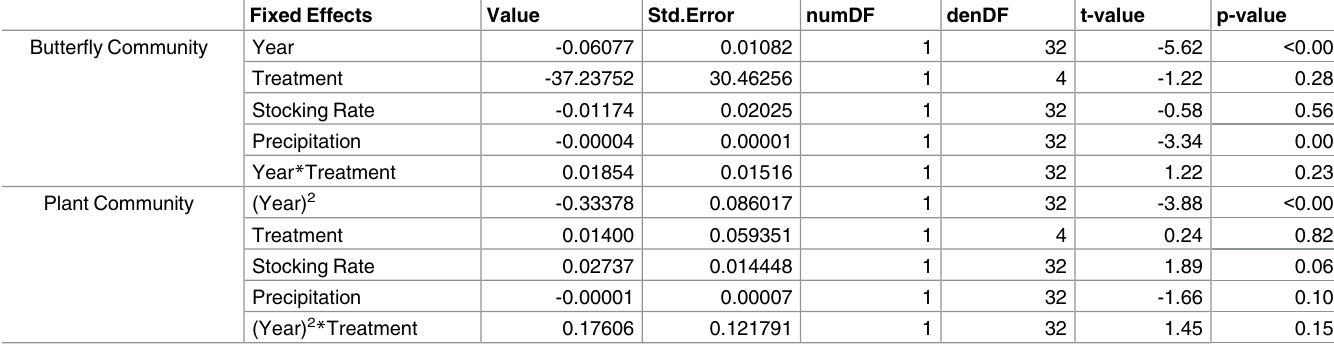
Table 3. Results of linear mixed-effects model analyses of change in dissimilarity of the butterfly community and plant community. Bray-Curtis dissimilarity was calculated between grazed sites and the averageof reference sites within each year. Models included year (2007–2013), treatment (patch- burn graze and graze-and-burn), stocking rate of each site (AUM ha -1 ), and growing season precipitation as fixed effects. Table presents both the numerator (num) and denominator(den) degrees of freedom (DF). Stocking rate was includedin the model because it changedeach year at each site (Table